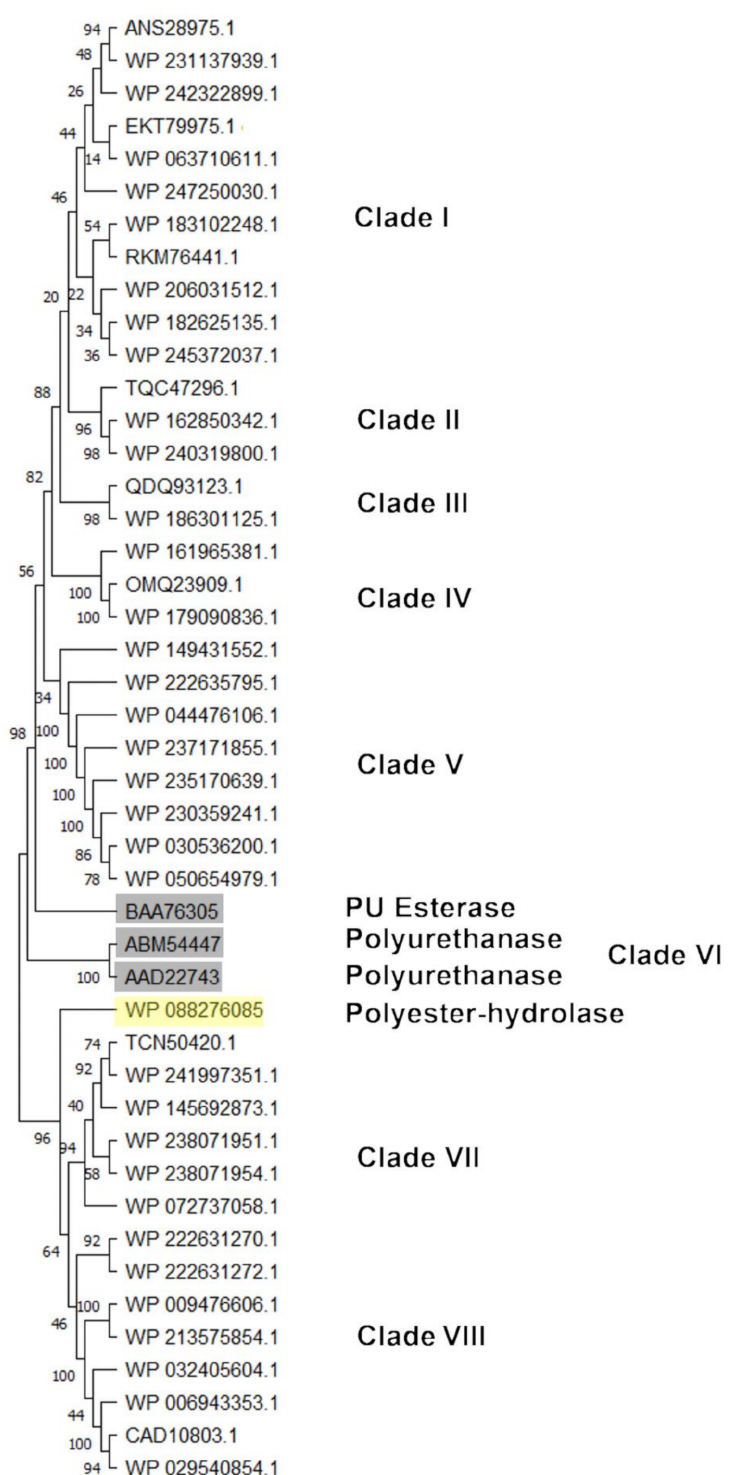
Figure 11. Subtree clusterization of HIT sequences identified by PU esterase and polyurethanase input gene putatively involved in heteroatomic backbone plastic degradation. Marked boxes evidence the reference input